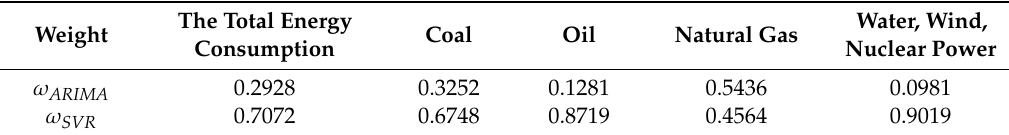
Table 8. Weight distribution of